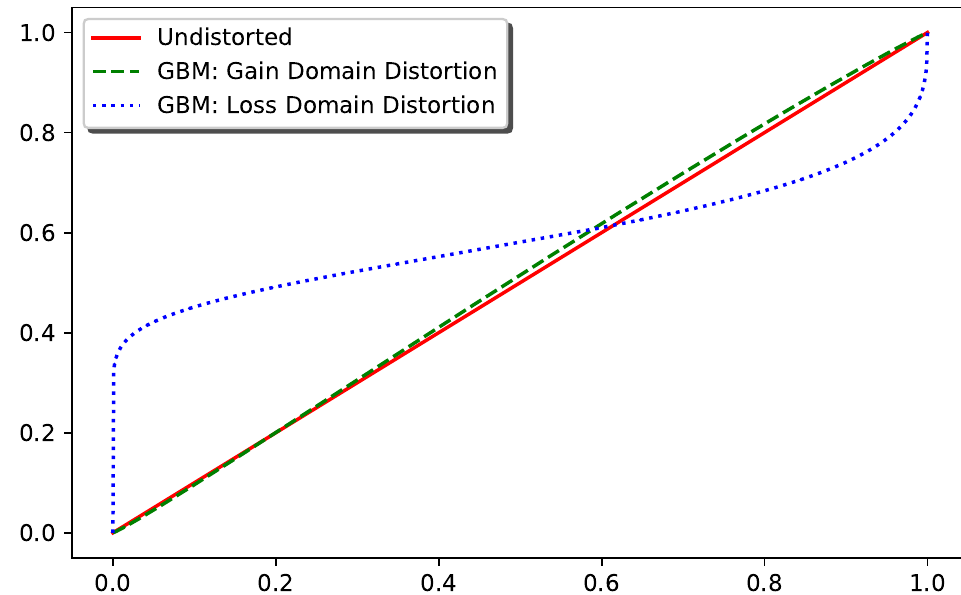
Figure 2. Distortion functions for the GBM model with mean probability distortion values γ = 1.051 and δ = 0.97 for the gain domain and γ = 0.316 and δ = 0.611 for the loss domain.